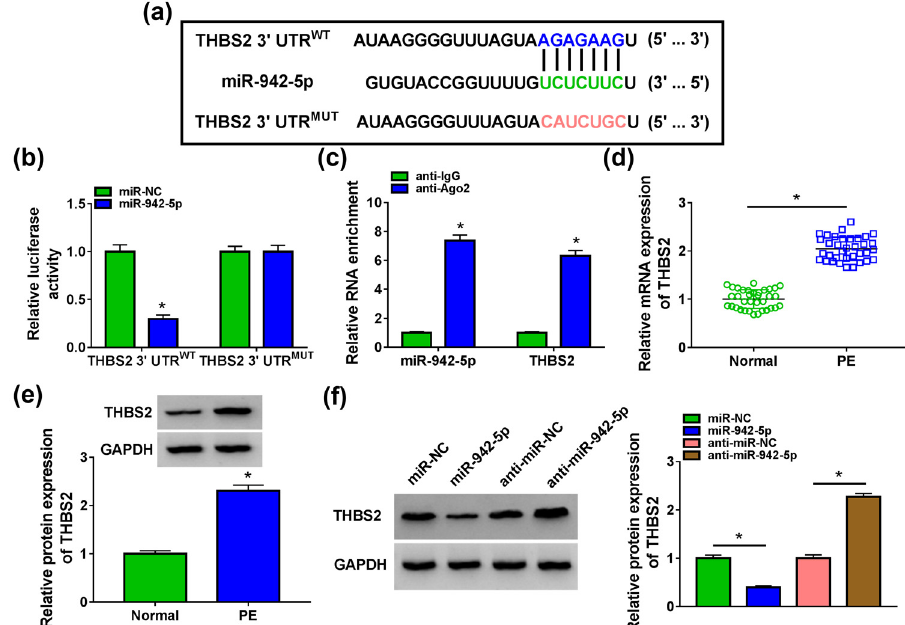
Figure 5: miR - 942 - 5p could target THBS2. ( a ) The sequences of THBS2 3 ′ - UTR WT/MUT vectors were presented. Dual - luciferase reporter assay ( b ) , and RIP assay ( c ) were used to verify the interaction between miR - 942 - 5p and THBS2. ( d and e ) The mRNA and protein expression of THBS2 in the placental tissues of PE patients and normal pregnant women were examined by qRT - PCR and WB analysis. ( f ) The protein expression of THBS2 was determined by WB analysis in HTR - 8/SVneo cells transfected with miR - 942 - 5p mimic and inhibitor. * P <